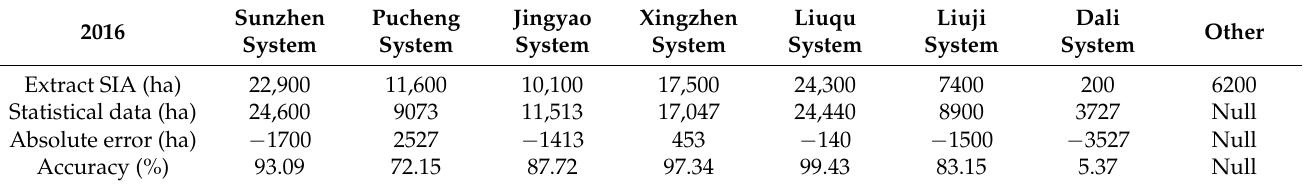
Table 4. Comparison of the SIA monitoring results and statistical data of each irrigation system in